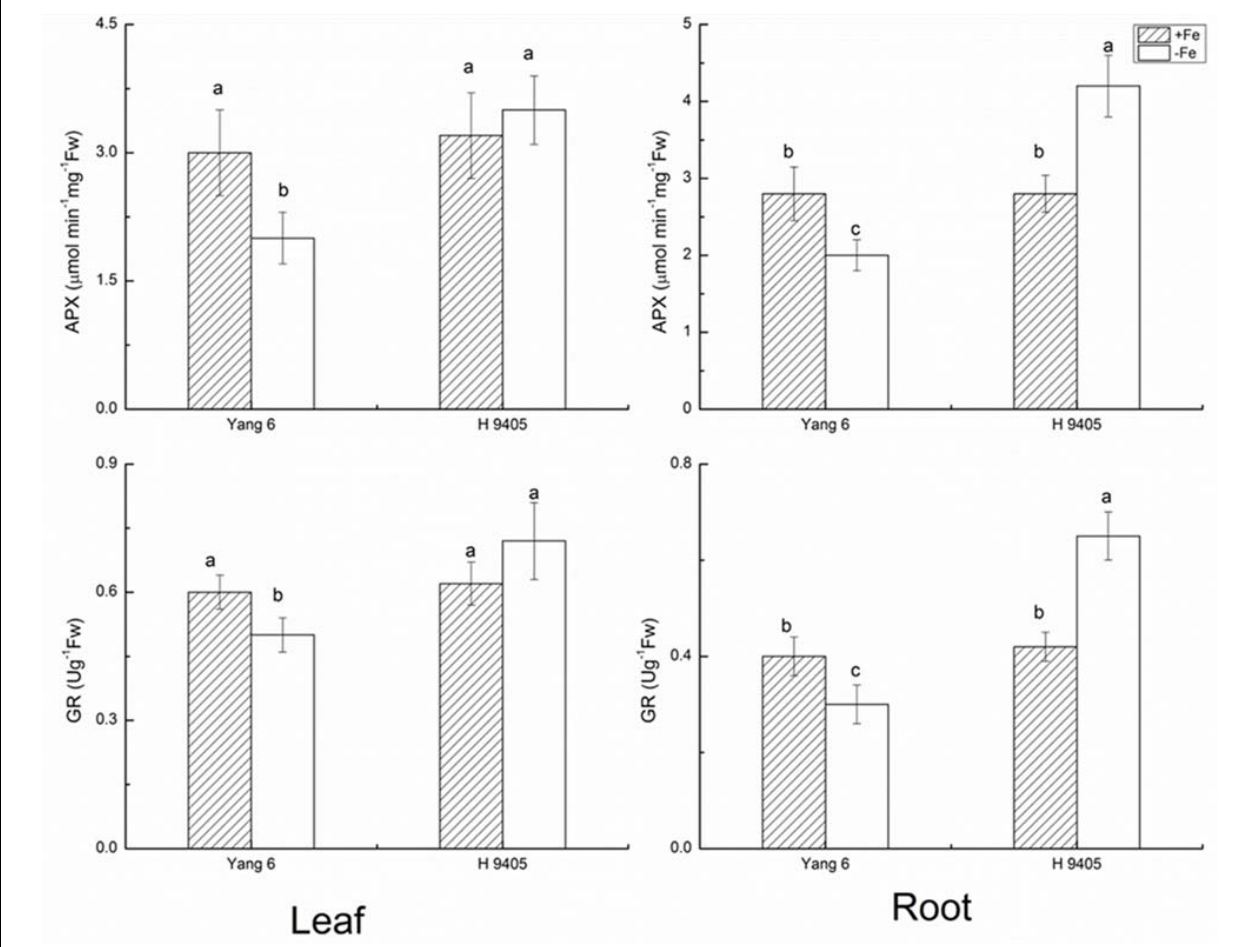
FIGURE 3 | Effects of iron deficiency on APX and GR contents in leaves and roots of rice seedlings. Data are presented as means ± SE of three biological replicates. Significant differences among treatments are indicated by different letters as determined by Duncan’s test ( P <